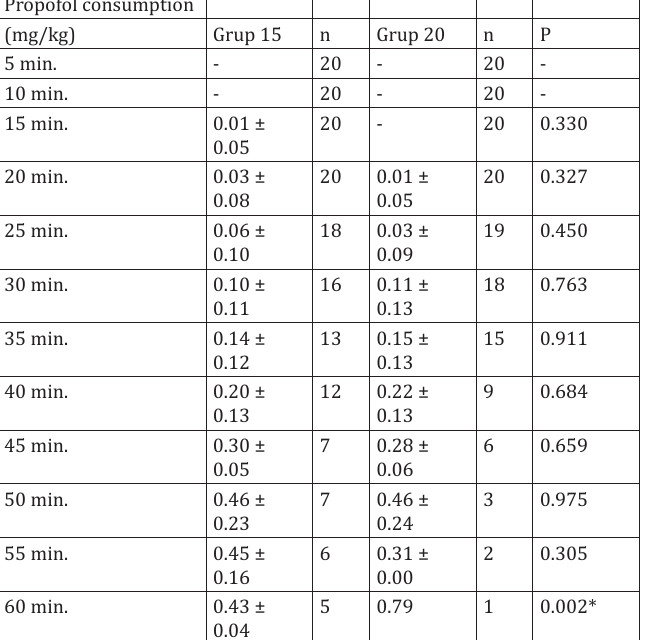
The distribution of the propofol